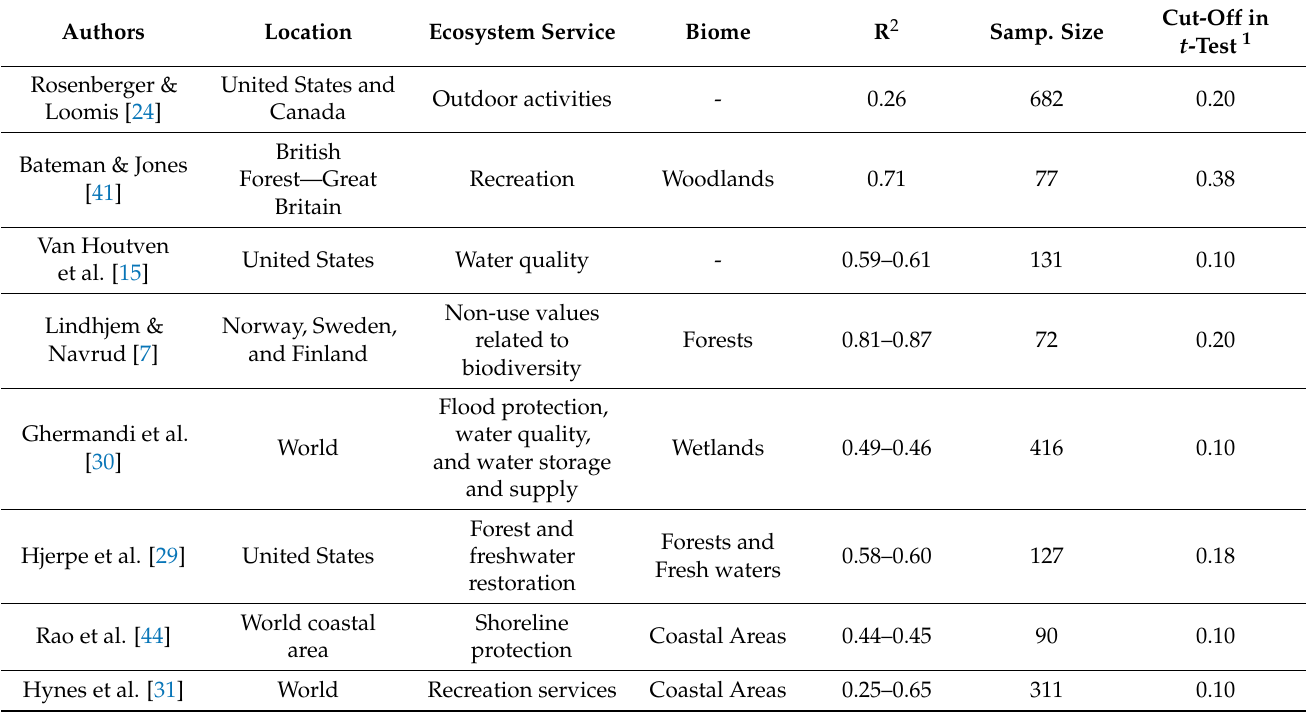
Table 5. Studies applying the meta-analysis for